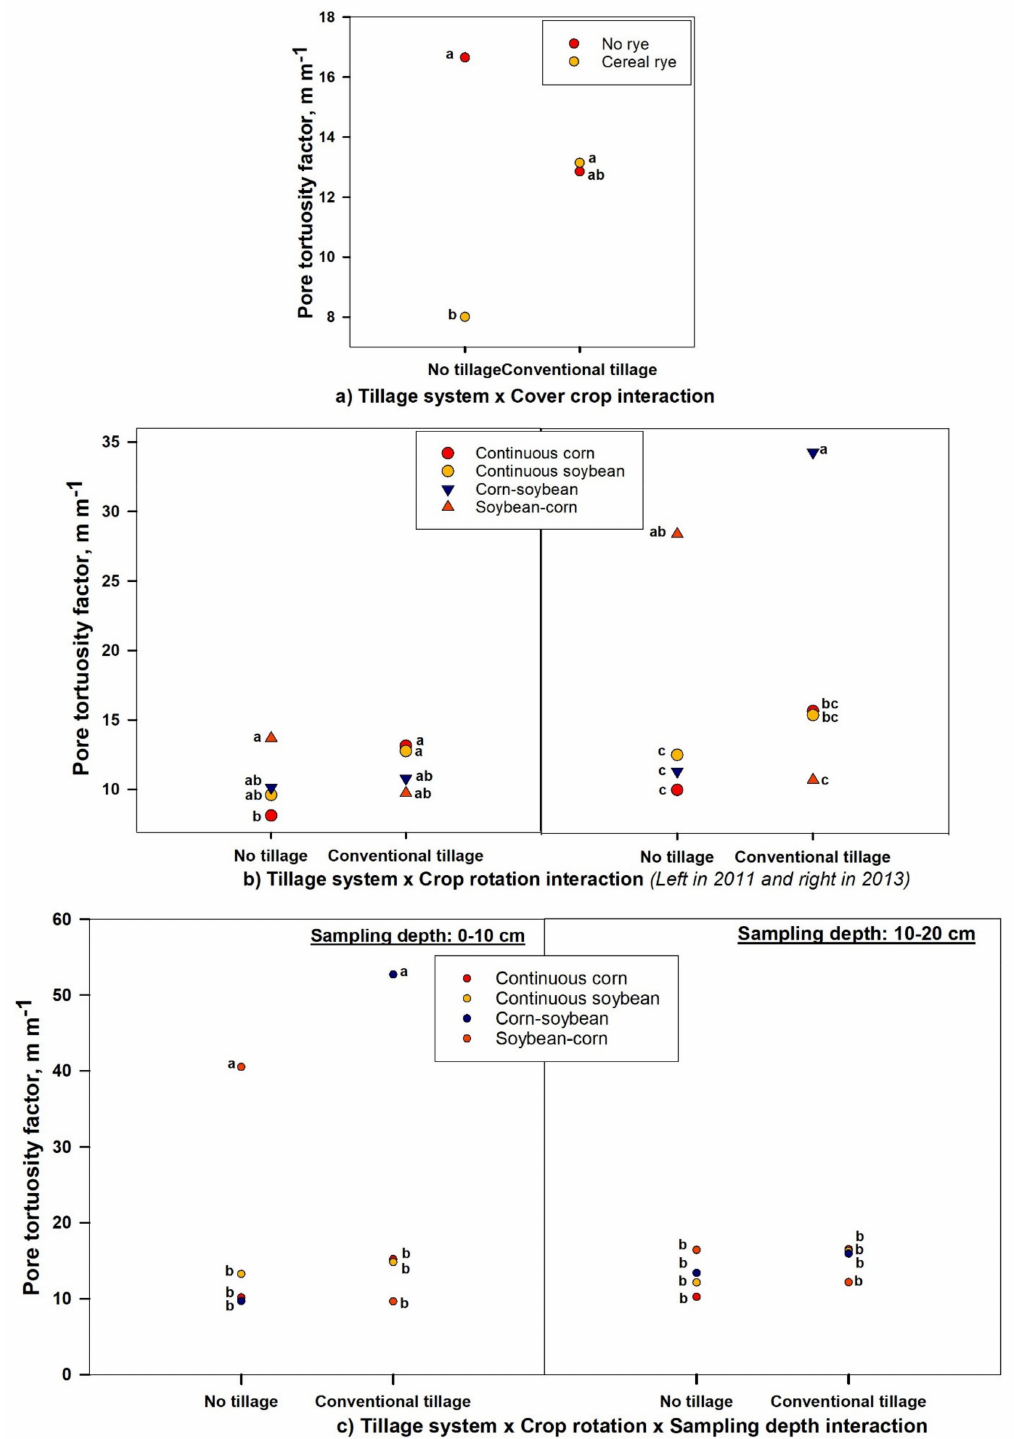
Figure 4. Interaction effect of different treatments on means of pore tortuosity factor: ( a ) tillage system × cover crop in 2012, ( b ) tillage system X crop rotation in 2011 (left) and 2013 (right) and ( c ) tillage system × crop rotation × sampling depth in 2013. Means followed by same lowercase letter are not significantly